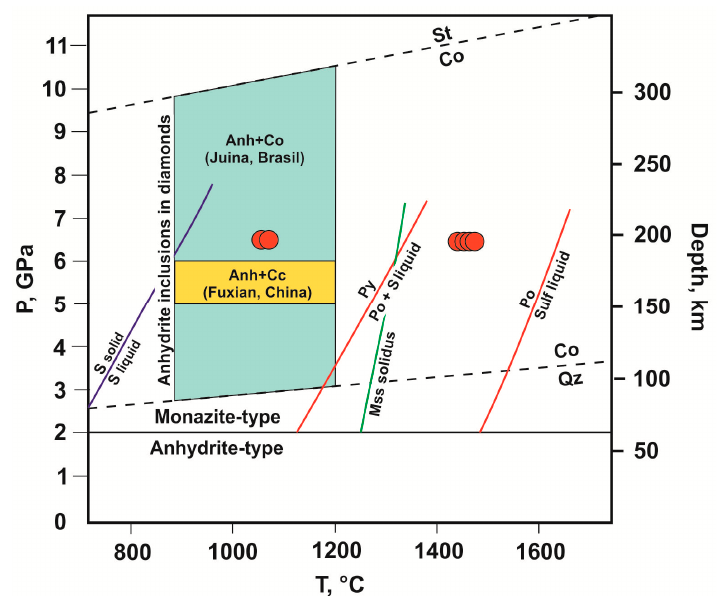
Figure 1. P-T diagram with experimental parameters (circles), line of structural transition of anhydrite [17], estimated field of the formation of diamonds with anhydrite inclusions [10,11,30], and experimentally determined melting curves of sulfur, pyrrhotite, and Mss and decomposition of pyrite [31–33]. Sulf —sulfide, Po —pyrrhotite, Py —pyrite, Mss —monosulfide solid solution (Fe 0.69 Ni 0.23 Cu 0.01 S 1.00 ), Anh —anhydrite, Co —coesite, St —stishovite, Qz —quartz, Cc —calcite.